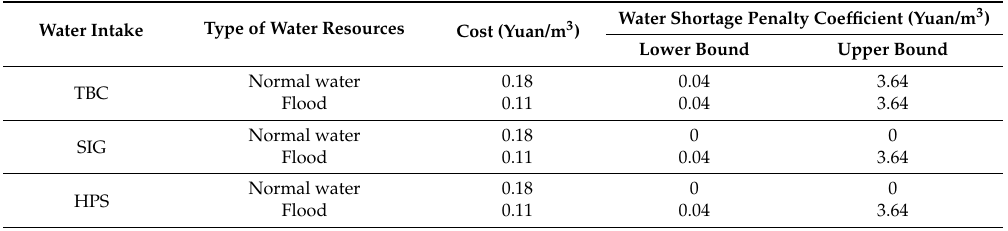
Table 5. Water diversion cost [28] and water shortage penalty coefficient of different water diversion methods (Section C in Supplementary